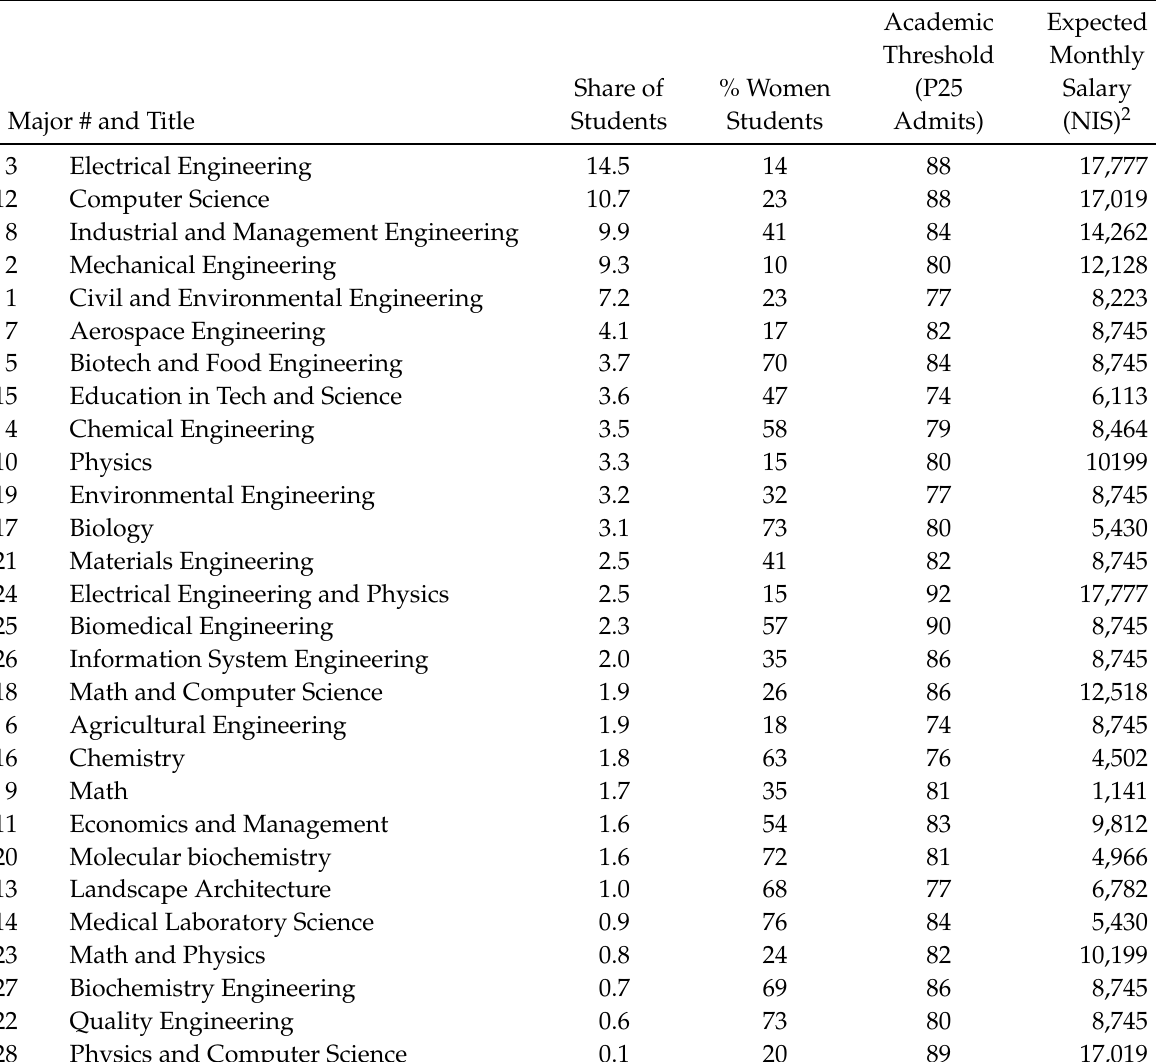
Table 1: Fields of Study and Selected Characteristics, TECH 1998–2008